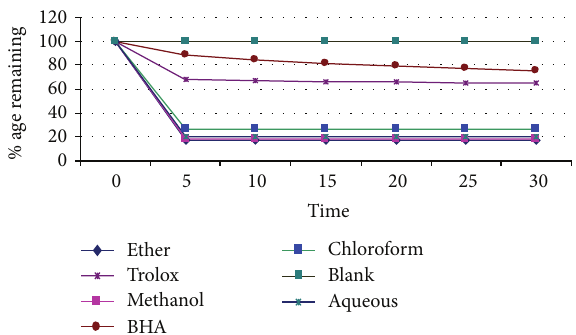
Figure 20: DPPH kinetic curve of fruit extract of C. ambrosioides .